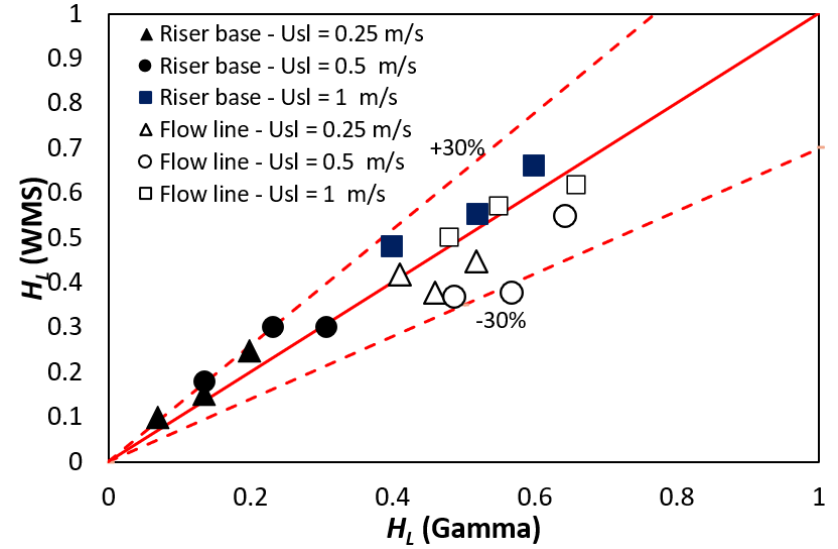
Figure 3. Cross validation of gamma densitometer and WMS mean liquid holdups at various u sl conditions for both the flowline and riser base injections.